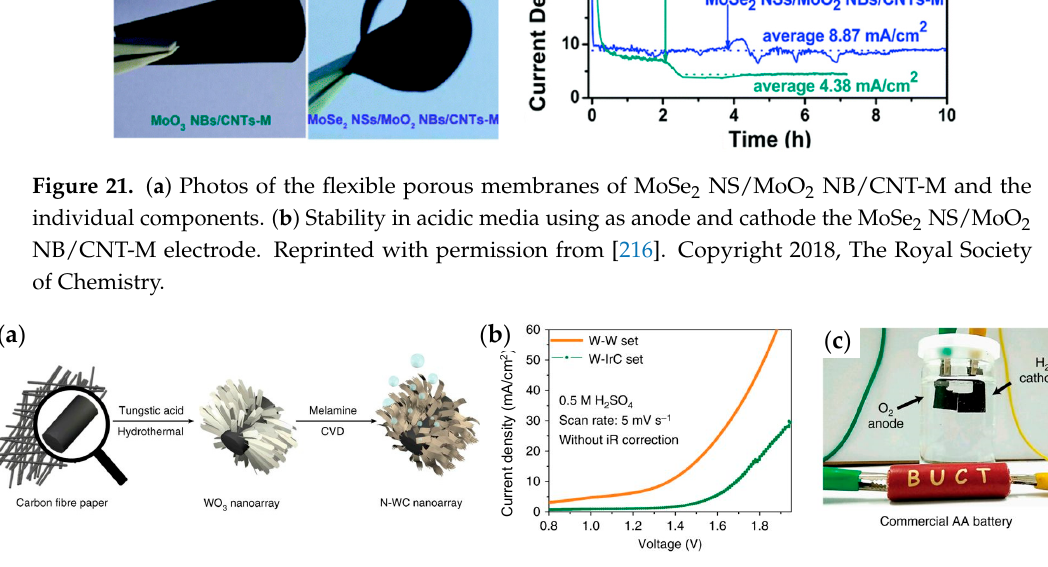
Figure 21. ( a ) Photos of the flexible porous membranes of MoSe 2 NS/MoO 2 NB/CNT ‐ M and the individual components; ( b ) Stability in acidic media using as anode and cathode the MoSe 2 NS/MoO 2 NB/CNT ‐ M electrode. Reprinted with permission from [216]. Copyright 2018, The Royal Society of Chemistry.